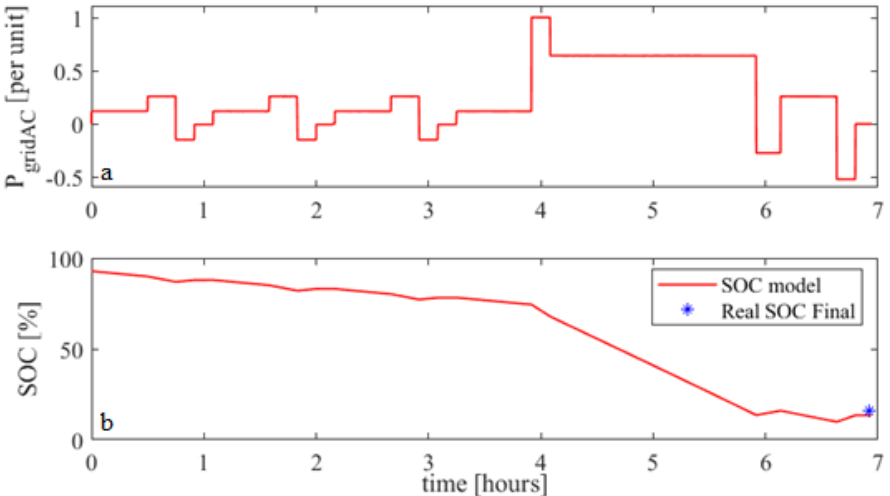
Figure 13. Power requested ( a ) and SOC evolution estimated by model ( b ) during the verification test.